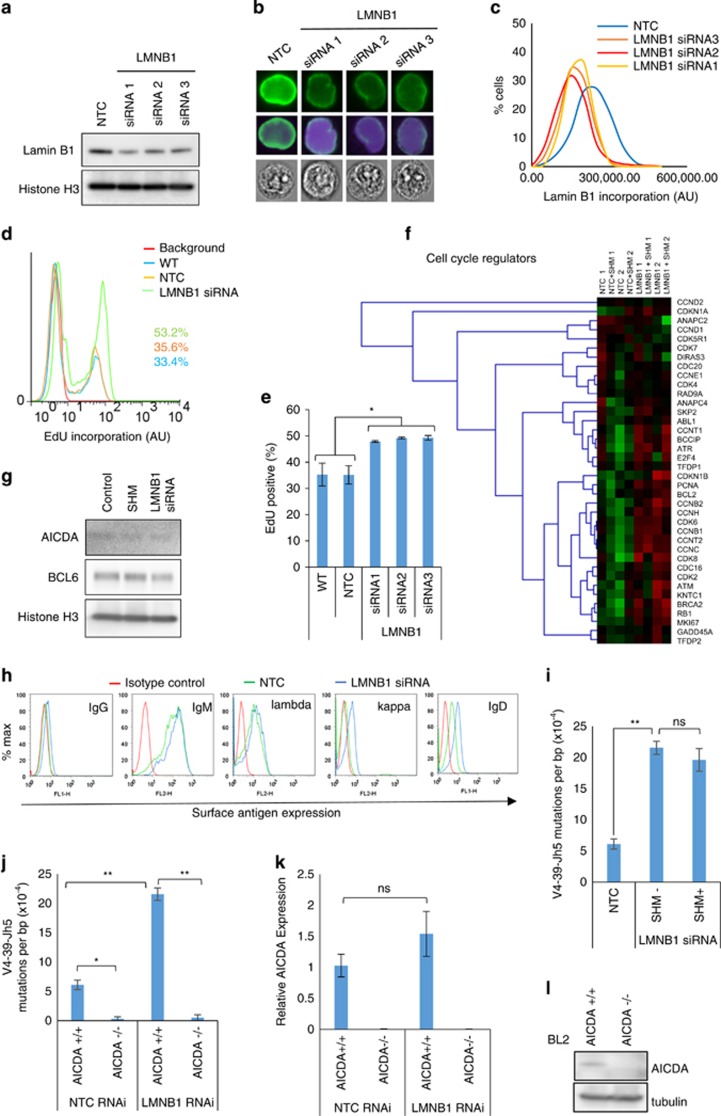
RNAi-mediated reduction of nuclear Lamin B1 results in acute proliferation boost, de-novo surface antigen expression and AICDA-dependent somatic mutations. (a) Three different LMNB1 mRNA-targeting siRNAs were nucleofected into BL2 cells and then total Lamin B1 protein level was assessed by western blotting 48 h post electroporation. (b, c) High throughput Lamin B1 nuclear incorporation was assessed by ImageStream cytometry 48 h after siRNA treatment. At least 8000 cells were analysed per sample. Nuclei were counterstained with DAPI. (b) Representative cells showing Lamin B1 fluorescence within the median of sample intensity distributions. (c) Histograms showing absolute value distributions for non-targeting siRNA control (NTC) or LMNB1 siRNA-treated cells. (d, e) EdU was added to WT, NTC or siRNA-treated cells 72 h post siRNA treatment for 2 h and then the proportion of EdU+ cells was assessed by FACS. (d) Representative EdU FACS profile showing 33% proliferation boost in siRNA2, as compared with NTC-treated cells. (e) The average percentage of EdU+ cells from three independent experiments±s.e.m. P<0.02. (f) Expression profiles of cell cycle regulatory genes in SHM-induced and/or LMNB1 siRNA-treated BL2 cells. (NTC: control with non-targeting siRNA; NTC SHM: control with non-targeting siRNA and after induction of SHM; LMNB1: LMNB1 RNAi transfected; LMNB1 SHM: LMNB1 RNAi transfected and after induction of SHM. Experiments were conducted in two independent BL2 cell passages indicated with ‘-1’ and ‘-2’ behind the experiment label. For siRNA-treated samples, a SMARTpool LMNB1 siRNA mixture of three siRNAs (a–f), in equimolar concentration was used. (g) Western blot analysis of AID and BCL6 proteins in antibody- or LMNB1 siRNA-treated samples at 72-hour time point. Histone H3 was used as a loading control. (h) FACS analysis of Ig surface antigen expression. Surface IgG, IgM, IgD, as well as kappa and lambda-light chain expression was assessed 72 h after cells were treated with NTC or SMARTpool LMNB1 siRNA. For FACS, a fluorophore and isotype-matched non-targeting antibody was used to set background fluorescence. A representative of three independent experiments. (i–l) Mutations targeted to V4-39-Jh5 fragment are AICDA dependent. (i) Cells were treated with SMART pool LMNB1 siRNA and then mutations were assessed by Sanger sequencing 72 h post transfection. For combined antibody/siRNA-treated samples, SHM was induced 48 h after LMNB1 siRNA transfection, and then DNA was isolated 72 h after initial treatment. (j) Parental and AID-deficient BL2-clones were treated with LMNB1 RNAi and mutations induced in V4-39-Jh5 gene were analysed. *P<0.05, **P<0.01. (k) qPCR and (l) western-blot analysis of AICDA expression in BL2 wt and AID-/- cells treated with non-target control (NTC) or LMNB1 siRNA. Data represents the average of three experiments±s.e.m. P<0.01.